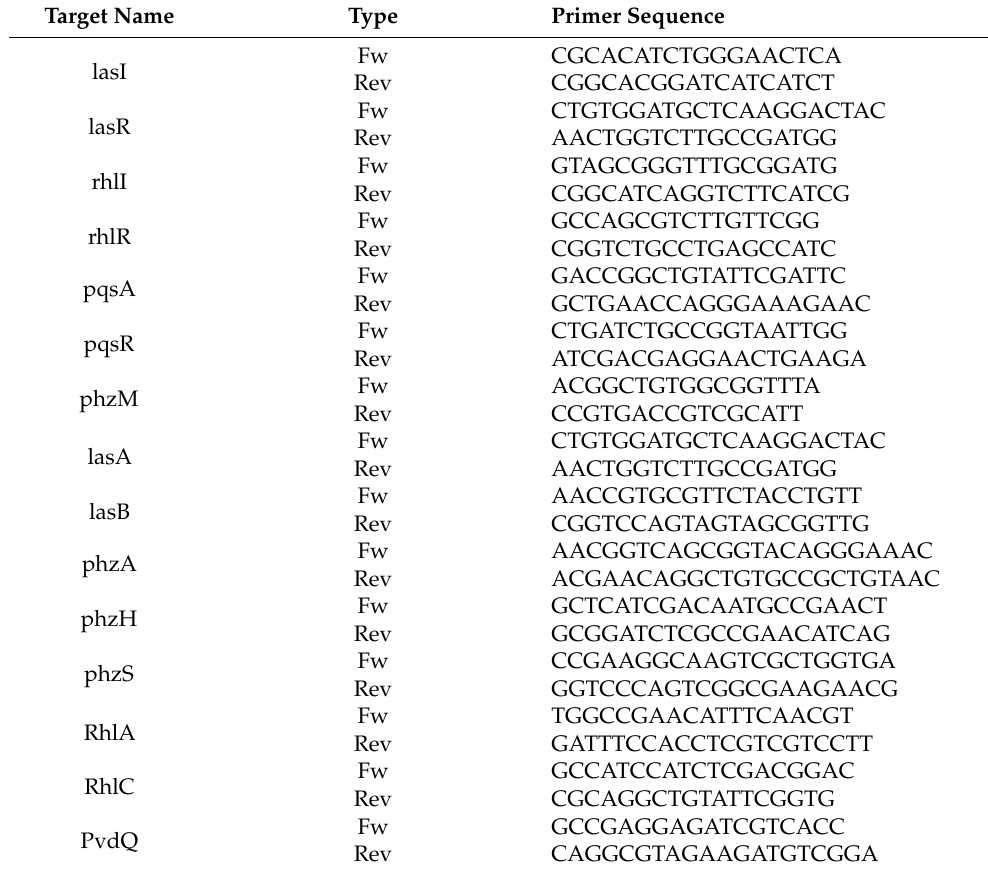
Table 1. List of primers used in